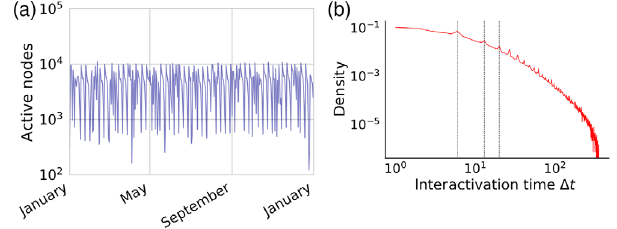
FIG. 12. Temporal analysis cattle trade in the year 2010. (a) Number of premises that trade at least once on a given day. (b) Interevent time distribution, i.e., the interval between subsequent trade events of an arbitrary farm. Vertical lines indicate 7, 14, and 21 days.